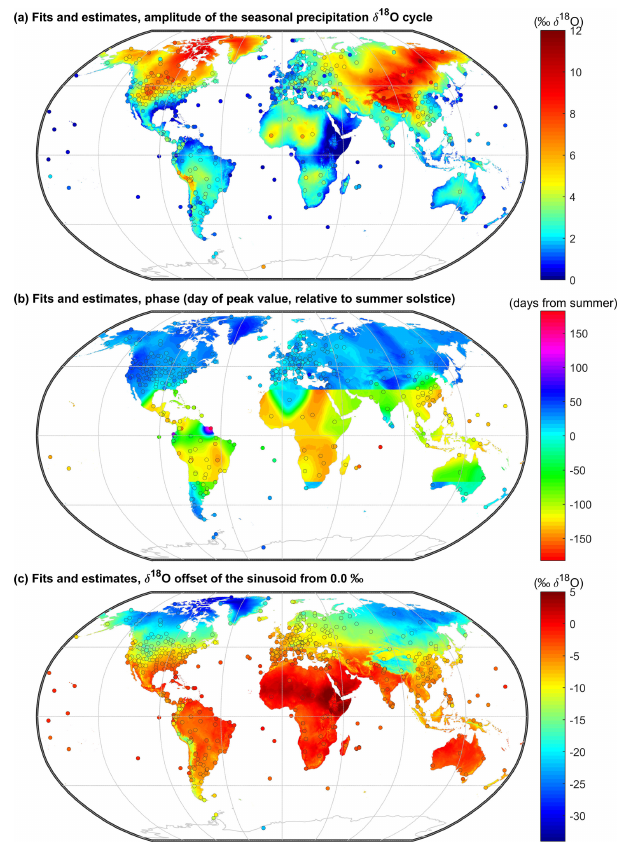
Figure 7. Maps of fitted station values (markers) and the residual- adjusted maps of sine-curve parameters (shaded) that describe the seasonal cycles in precipitation δ 18 O: (a) amplitude, (b) phase, and (c) offset. The interpolated surface is the sum of the infilled surfaces in Figs. 3 and 4 (see